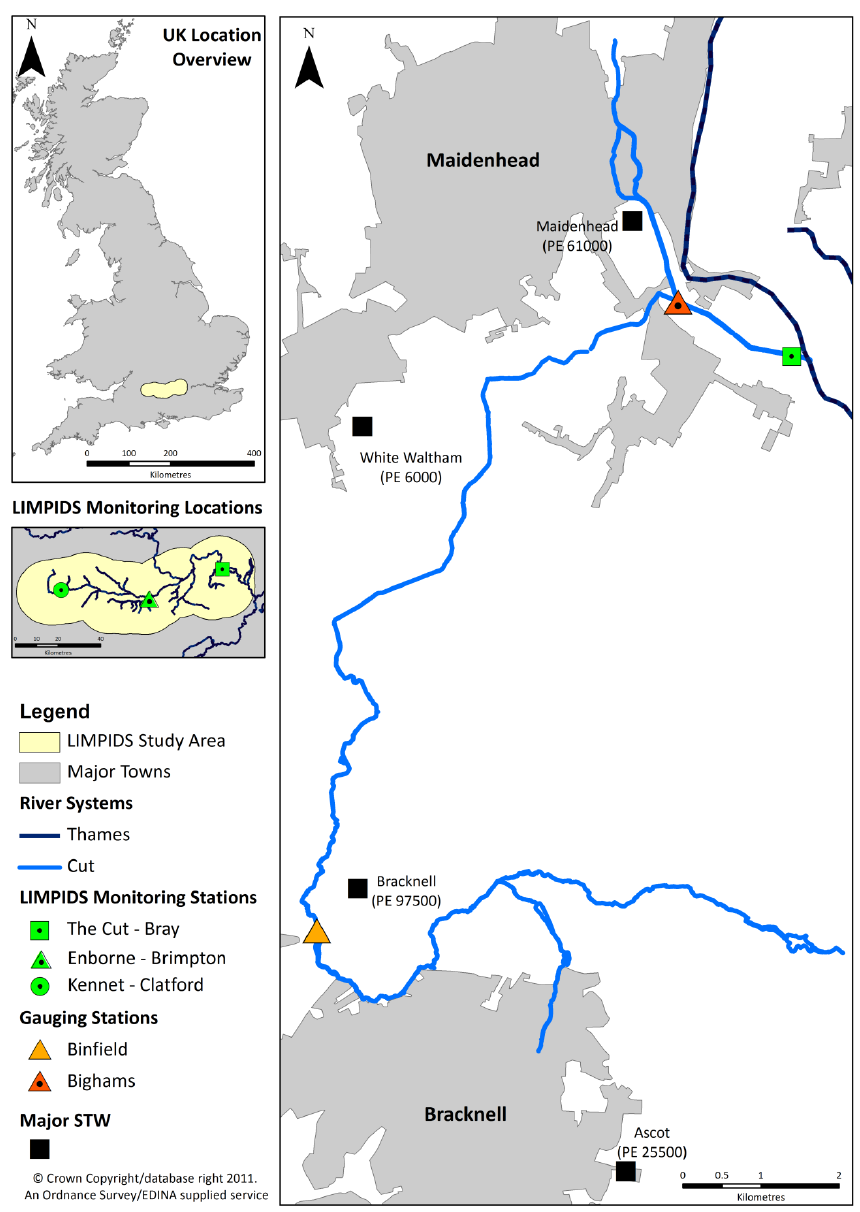
Figure 2 2 Fig. 2. The Cut study